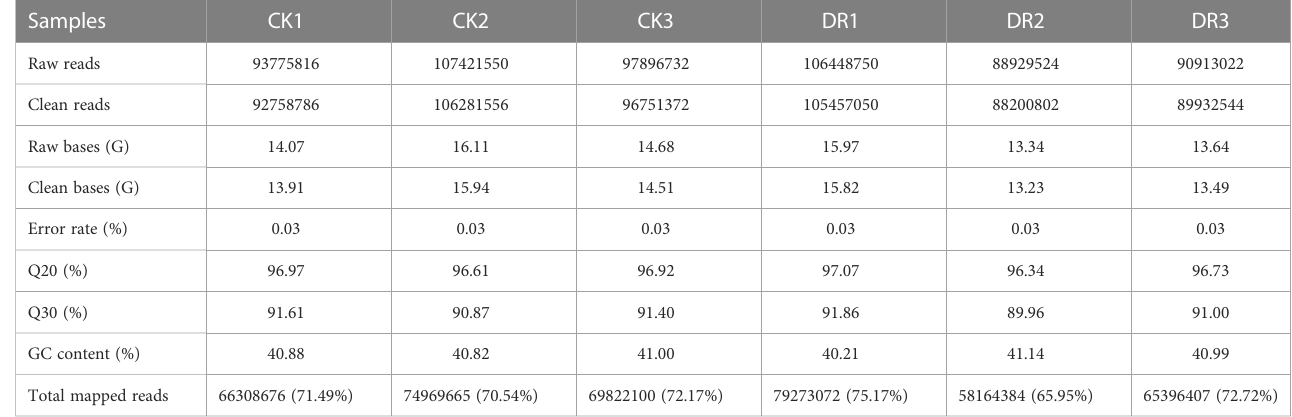
TABLE 1 RNA-seq data of six